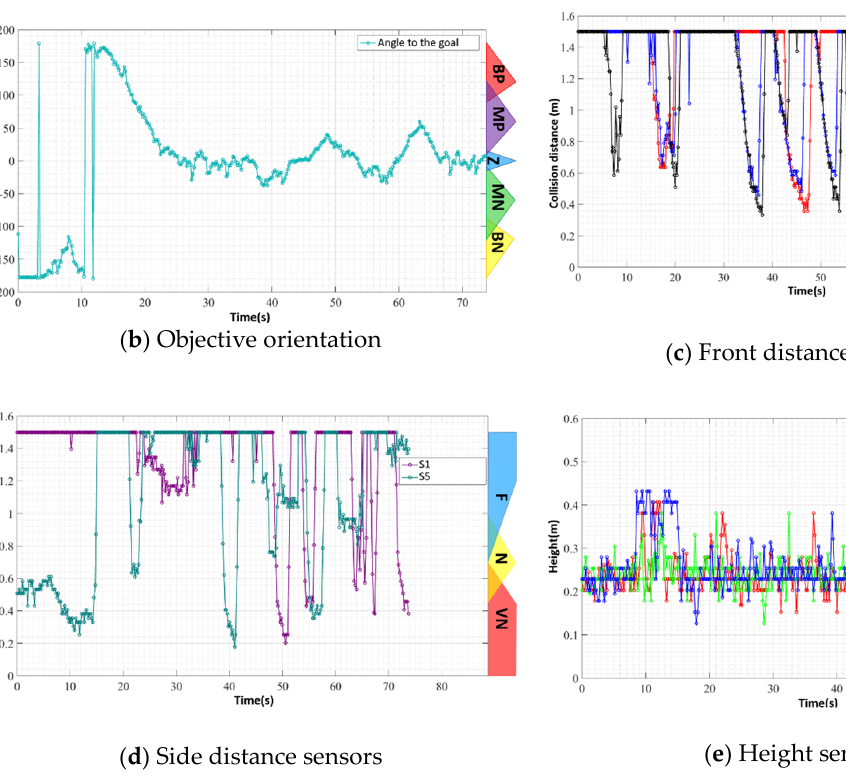
Figure 17. Sensor and actuator data during route 1.